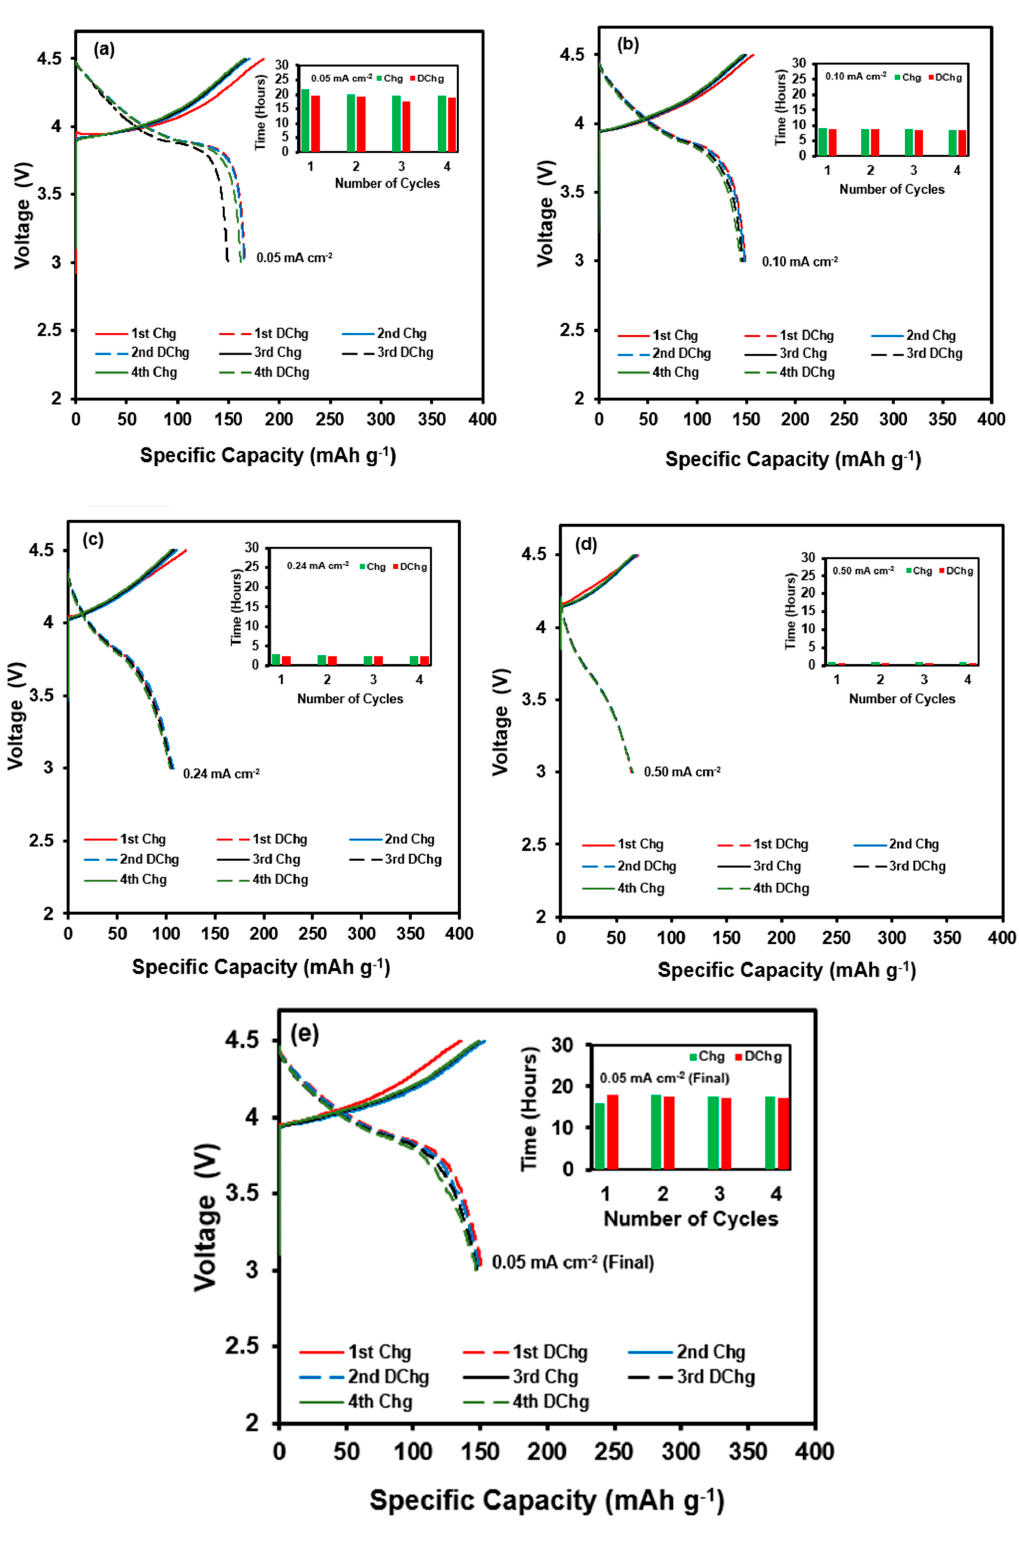
Figure 8. Charge–discharge voltage–time profiles and electrochemical performance of LiCoO 2 |LLCZN/PEO/LiPF 6 |Li cells with voltage window of 3–4.5 V at different currents ( a ) 0.05 mA cm − 2 , ( b ) 0.10 mA cm − 2 , ( c ) 0.24 mA cm − 2 , ( d ) 0.50 mA cm − 2 , and ( e ) 0.05 mA cm − 2 (final).